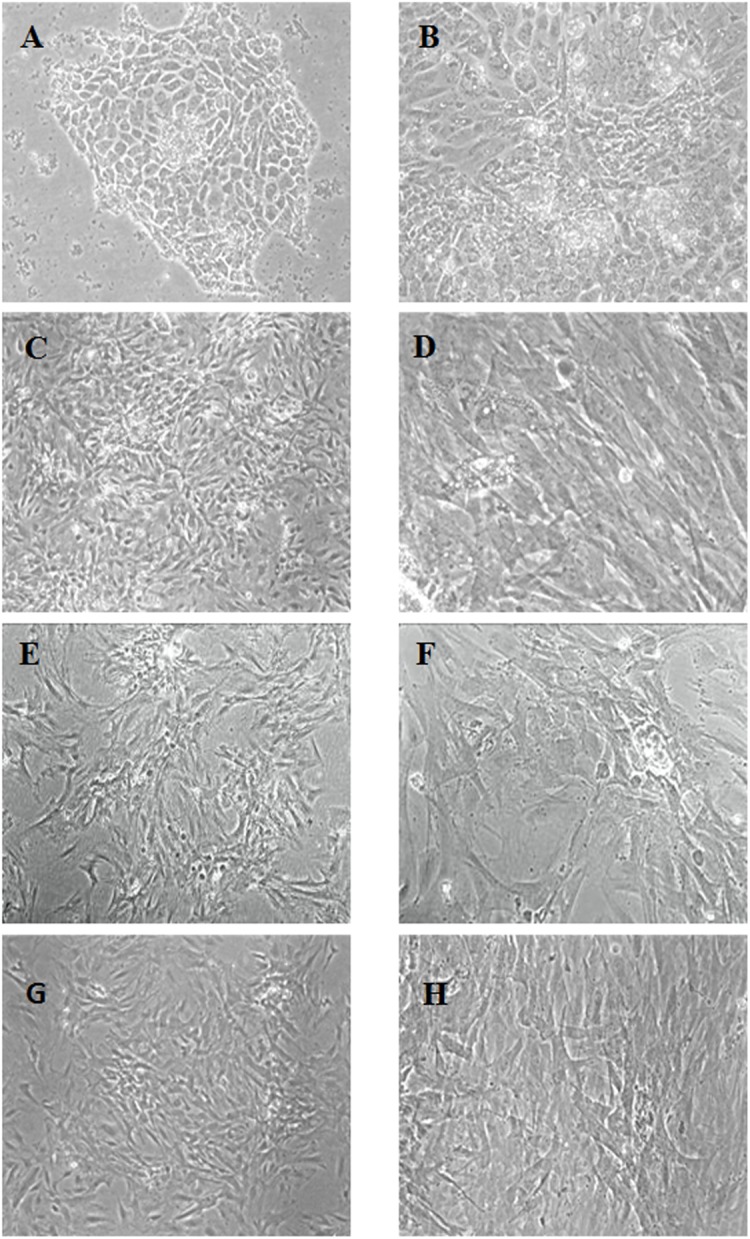
Morphological characterization of renal papillary cells.(A) Primary cell culture on day 3. Cells exhibited colony-like growth and diverse morphology. (B) Primary cell culture on day 5. Epithelioid and fibroblast-like morphologies were observed. (C,D) P2 cells after passage on day 5. (E,F) P3 cells showed a short fusiform or dendritic shape, and epithelioid cells had almost completely disappeared. (G,H) P5 cells exhibited a spindle-shape. (Magnification: C, E, G, ×40; A, B, F, H, ×100; D, ×200).